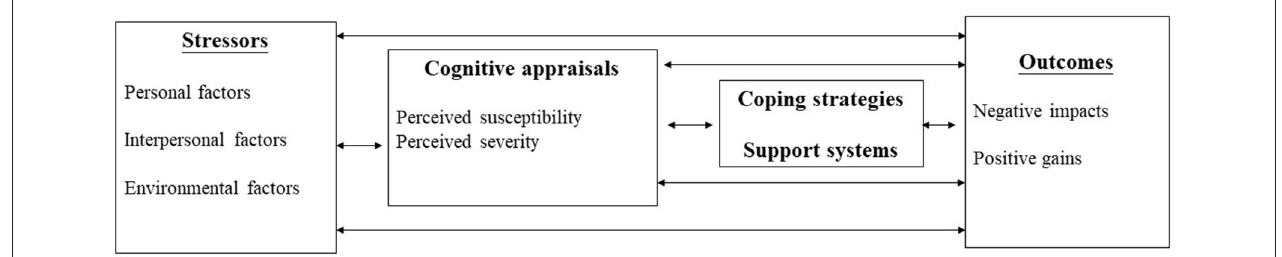
FIGURE 1 | The four components from Transactional Model of Stress and Coping